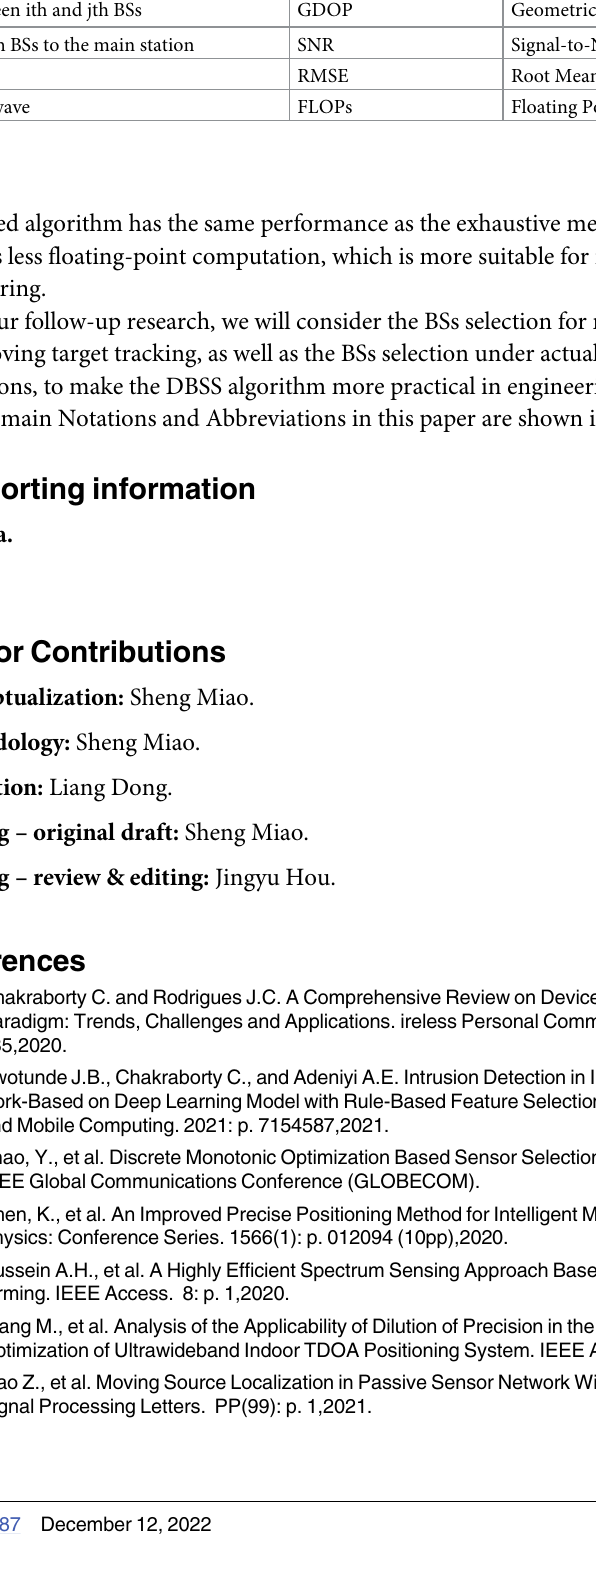
Table 2. A Table of mainly notation and abbreviation in this